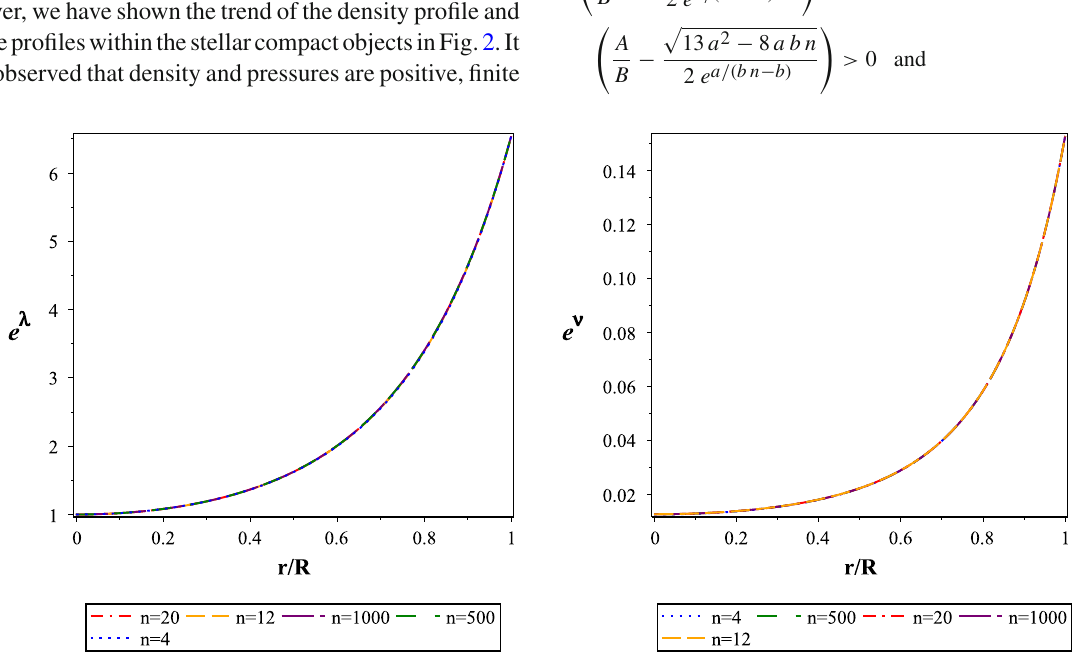
Fig. 1 Variation of the gravitational potentials e λ( r ) (left) and e ν( r ) (right) with respect to the radial coordinate ( r / R ). For purpose of plotting this figure , the numerical values of the constants for different parameters n are mentioned in Table